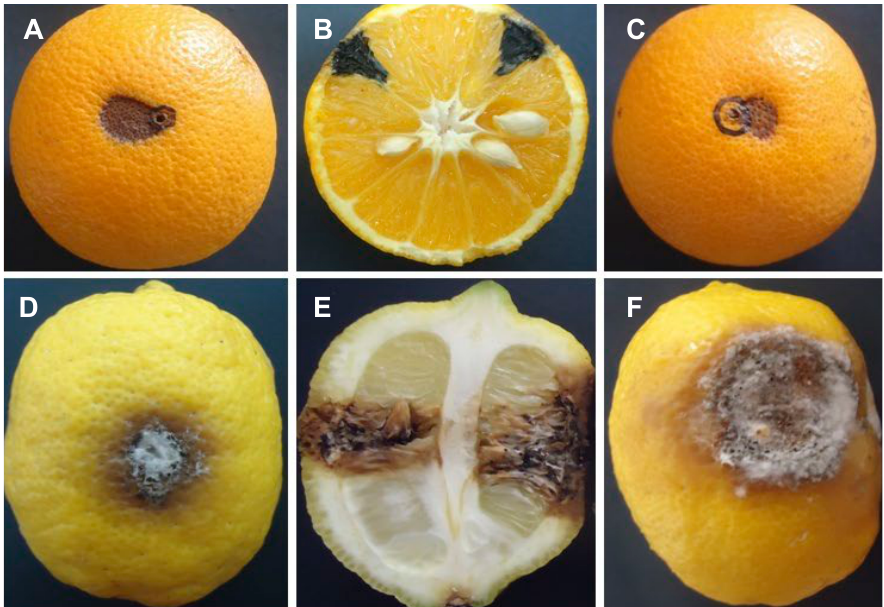
Figure 7. Lesions caused by Colletotrichum karstii (isolate C35) on artificially inoculated fruits of Valencia sweet orange (A and B) and on fruits of Eureka lemon (F). Lesions caused by C . gloeosporioides (isolate C31) on artificially inoculated fruit of Valencia sweet orange (C) and on fruits of Eureka lemon (D and